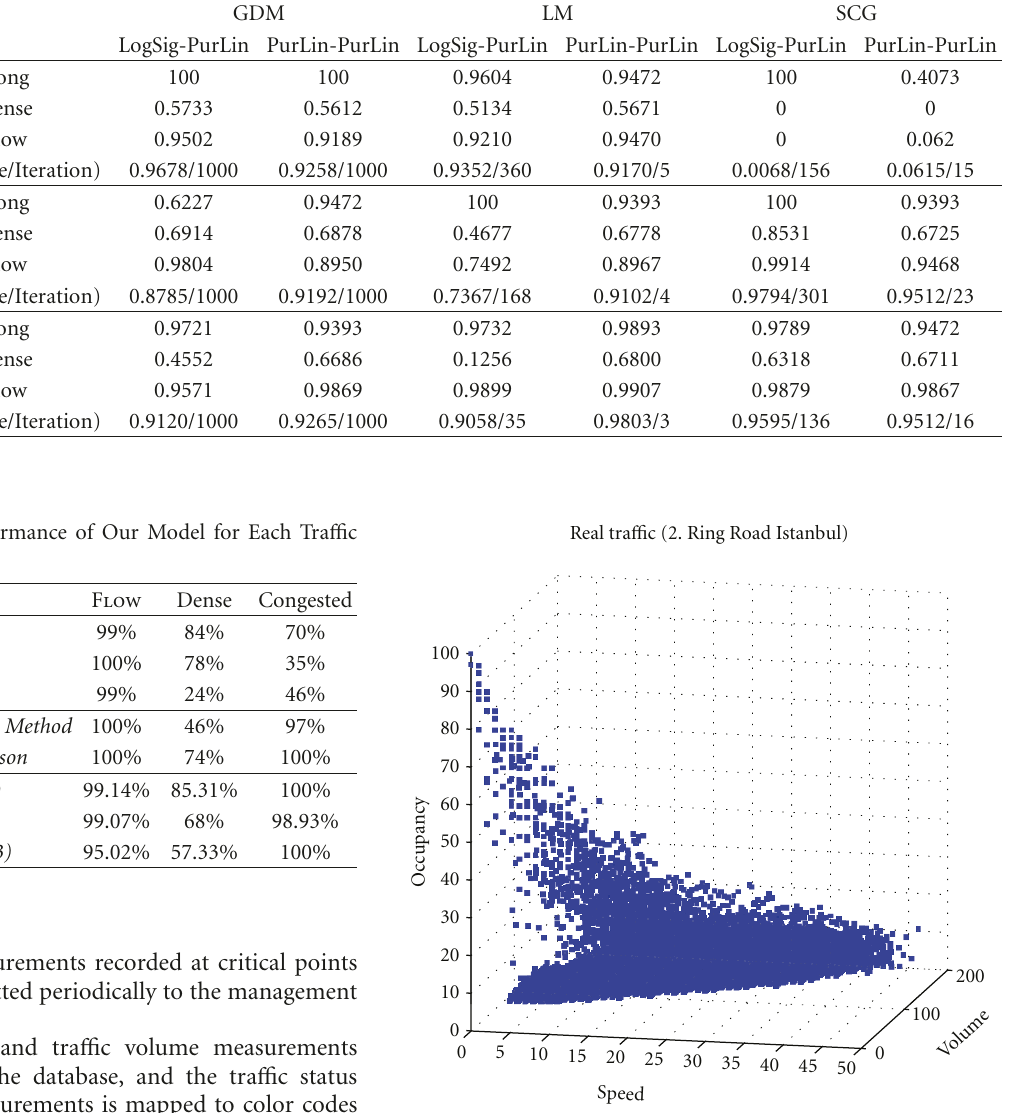
Table 1: Backpropagation Neural Net Performances.